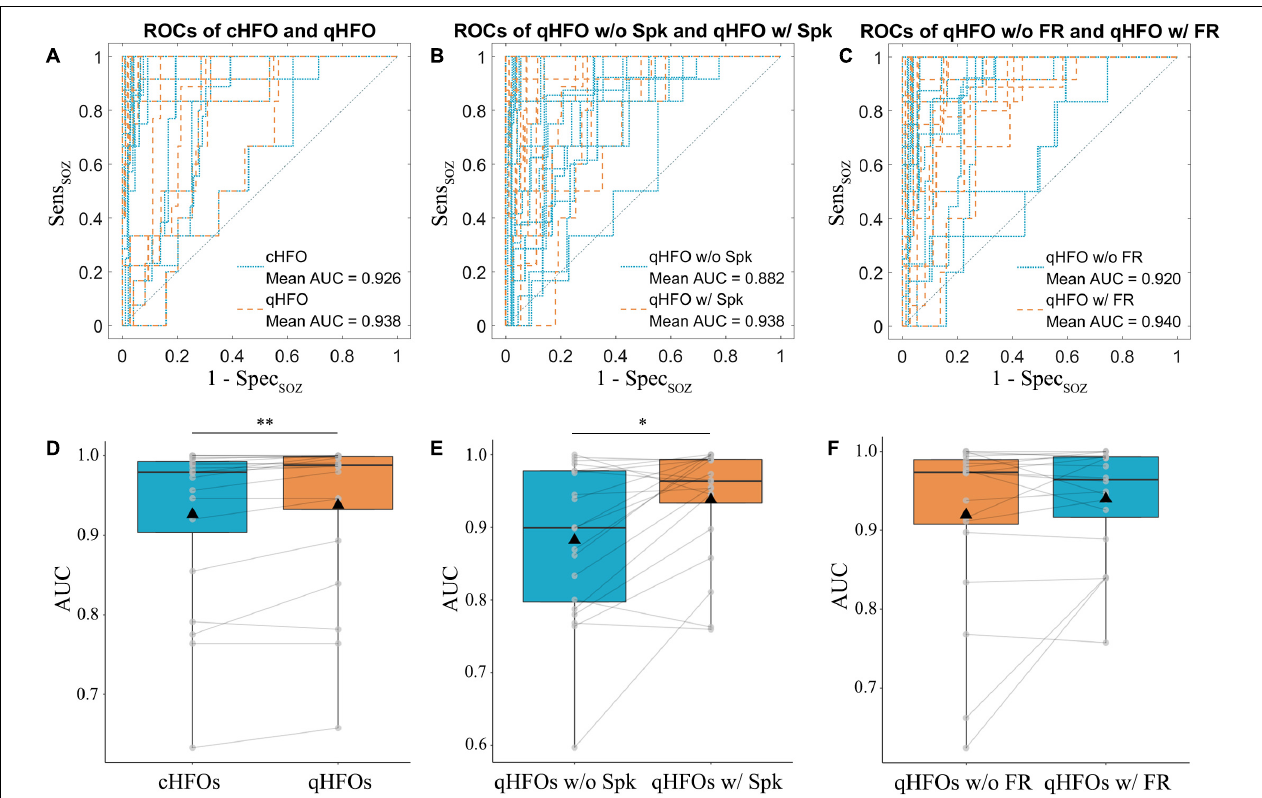
FIGURE 3 | ROC curves and AUC values of different event types in the testing cohort. ROC curves were plotted for each patient comparing cHFOs and qHFOs, (A) qHFOs with and without spike (B) and qHFOs with and without FR (C) . The corresponding AUC values were calculated with the trapezoid method. Significant differences were found between cHFOs and qHFOs ( p = 0.0043, Wilcoxon signed-rank test) (D) , qHFOs with and without spike ( p = 0.0111, Wilcoxon signed-rank test) (E) , but not qHFOs with and without FR ( p = 0.4209, Wilcoxon signed-rank test) (F) . * p < 0.05, ** p < 0.01. ROC: receiver operating characteristic; AUC: area under the curve; HFOs: high frequency oscillations; cHFO: candidate HFOs; qHFOs: quality HFOs; FR: fast ripple; w/: with; w/o: